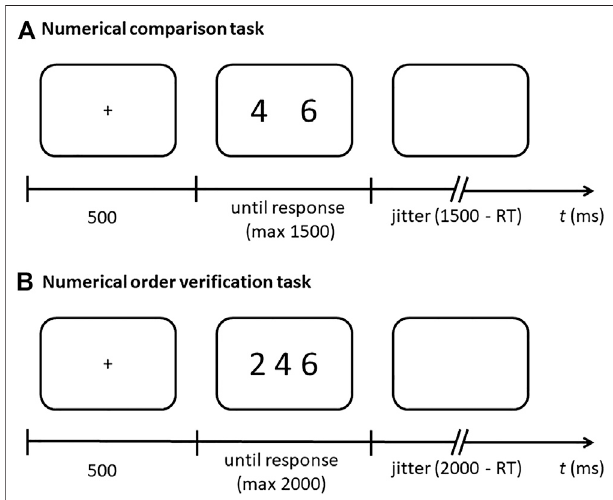
FIGURE 1 | Timing of a trial in (A) the numerical comparison and (B) the numerical order veri fi cation task. After showing a fi xation cross, the numbers were presented on the screen. Participants responded via a button